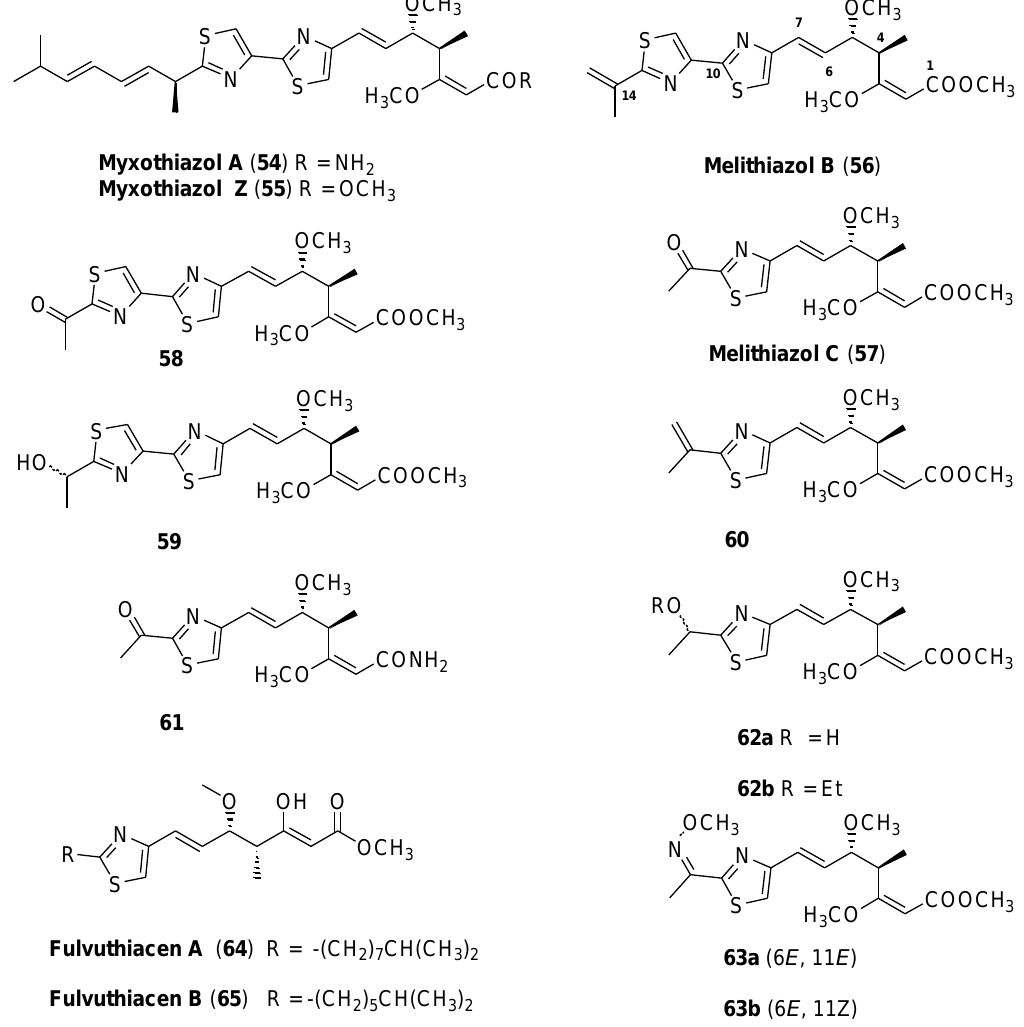
Figure 15 . Structures of mixothiazols, melithiazols, and fulvuthiacens . Figure 15. Structures of mixothiazols, melithiazols, and